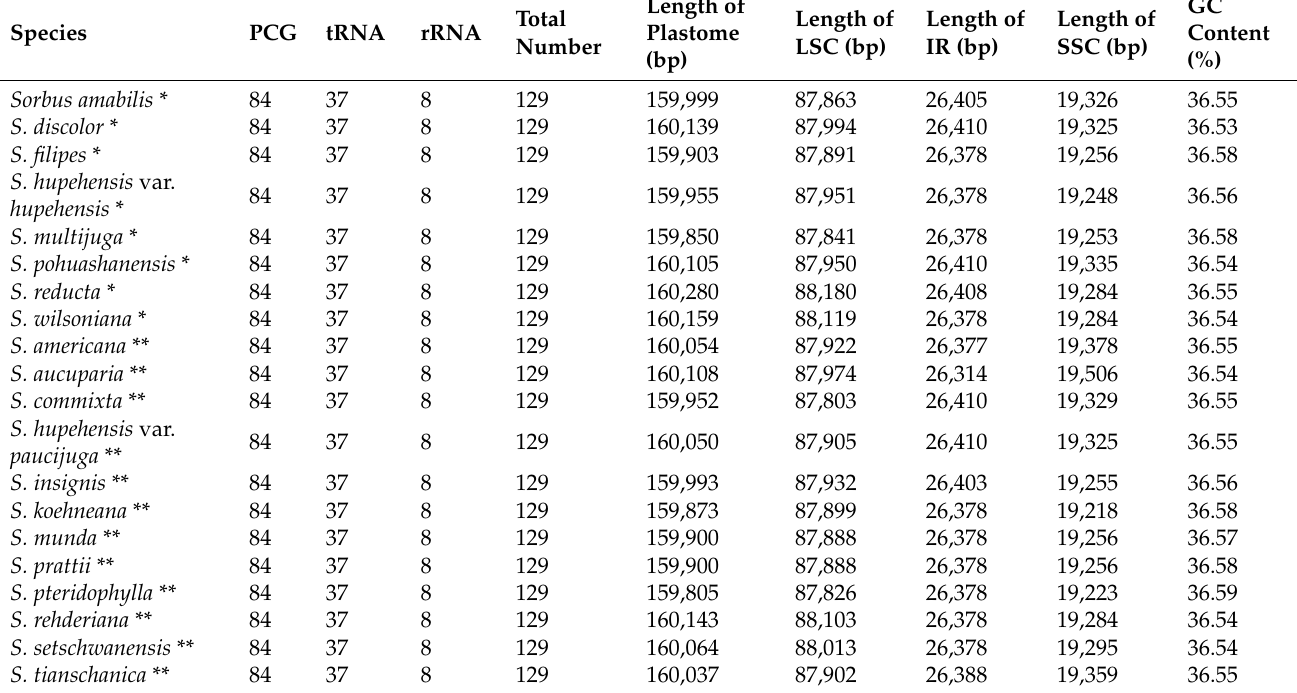
Table 1. Summary of complete plastomes of Sorbus